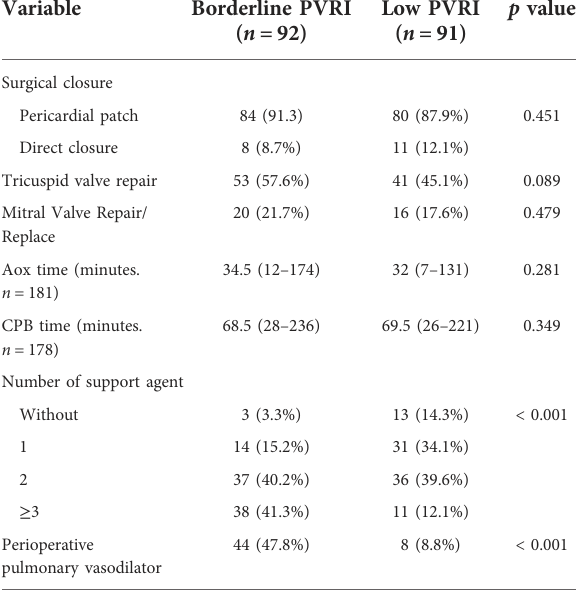
TABLE 3 Surgical procedures and ICU care in 183 secundum ASD patients underwent surgical closure.